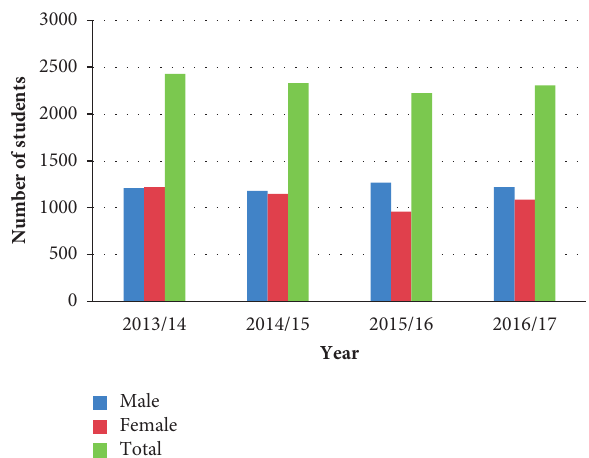
Figure 2: Enrollment trend of Kathmandu University in S&T